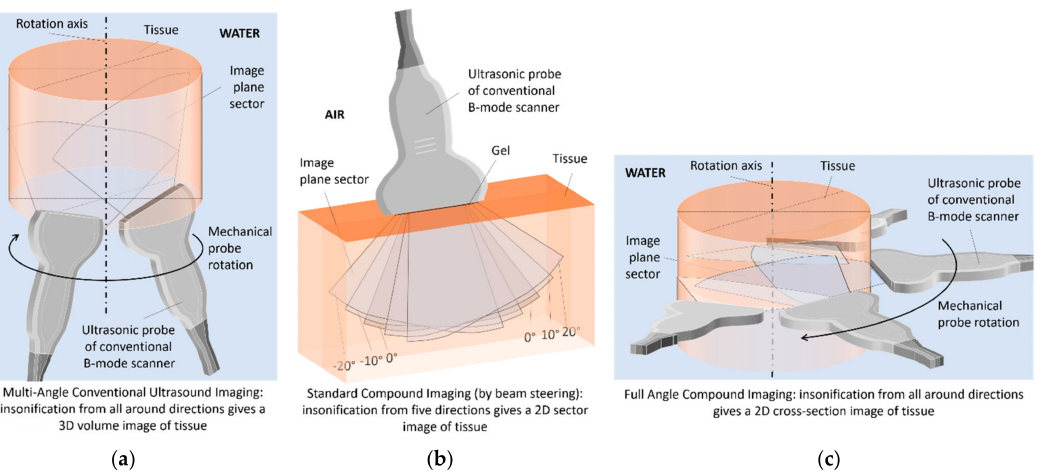
Figure 1. Scanning methods for different ultrasound compound imaging (CI) configurations: ( a ) in MACUI, ( b ) in HHUS, ( c ) in